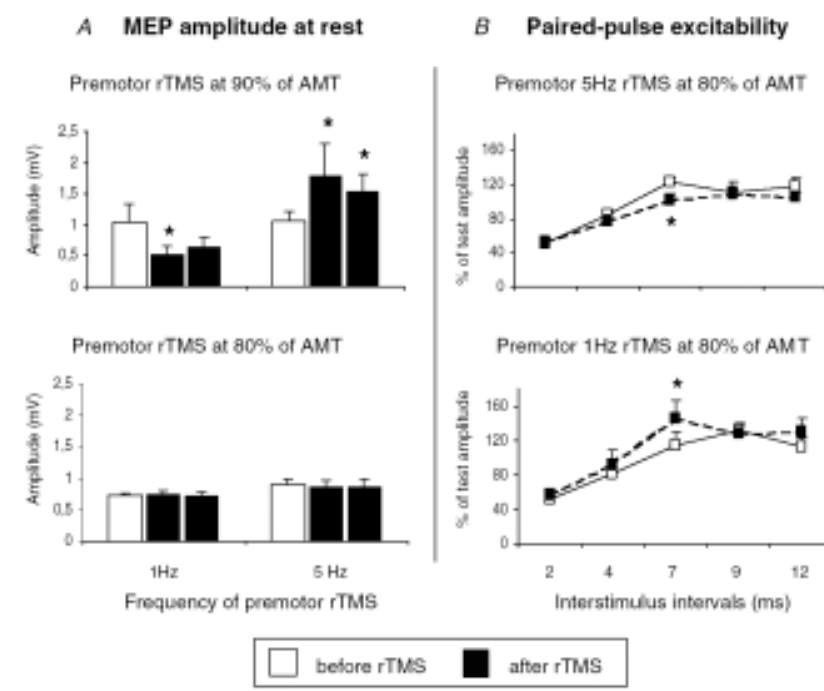
Fig. 1. Interactions between frequency and intensity of premotor rTMS on conditioning effects in the left M1hand. A: Conditioning effects on corticospinal excitability as indexed by the MEP amplitude at rest. The columns indicate mean MEP amplitudes before (white) and after premotor rTMS (black). B: Conditioning effects of premotor rTMS at 80% of AMT on paired-pulse excitability at an ISI of 7 ms. Error bars are standard error of the mean (S.E.M.). Asterisks denote a significant change relative to baseline. Used with permission from Rizzo et al. 2004